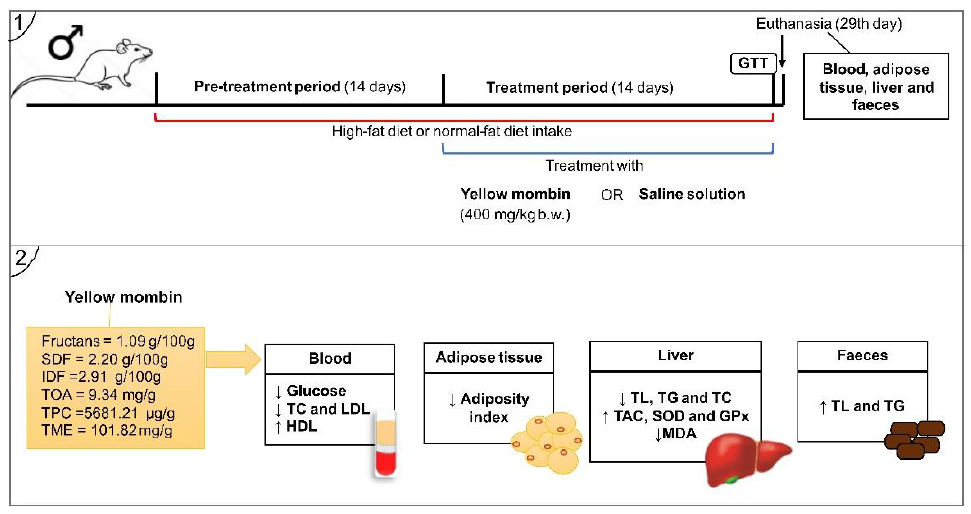
Figure 1. Experimental design. GTT = glucose tolerance test; HDL = high-density lipoprotein; IDF = insoluble dietary fibre; LDL = low-density lipoprotein; SDF = soluble dietary fibre; TC = total cholesterol; TAC = total antioxidant capacity; TG = triglycerides; TME = total mineral elements; TL = total lipids; TPC = total phenolic compounds; TOA = total organic acids. The respective diets were administered for four weeks to the rats. The high-fat diet groups received a high-fat diet with 6% lard, 5% non-hydrolysed vegetable fat, 1% cholesterol, and 0.5% cholic acid (Rhoster, Araçoiaba da Serra, SP, Brazil),